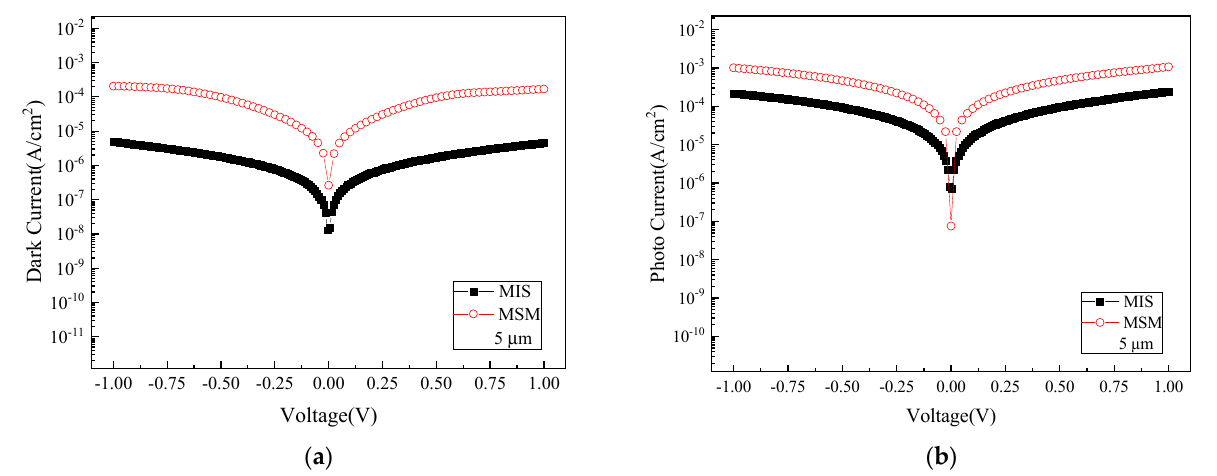
Figure 5. The current-voltage comparison between the MIS-based and conventional MSM photode- tectors: ( a ) the dark current and ( b ) photocurrent.